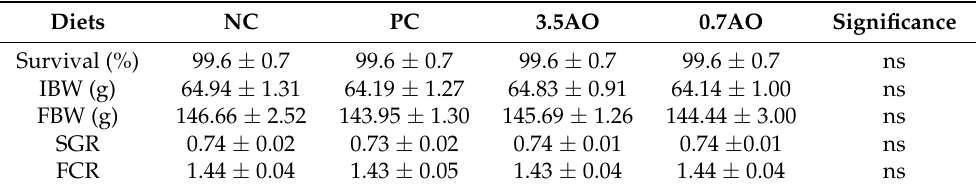
Table 2. Survival and zootechnical performance of gilthead seabream ( Sparus aurata ) fed diets supplemented with either fish oil (negative control (NC), positive control (PC)) or a percentage of microalgal oil (AO) for 110